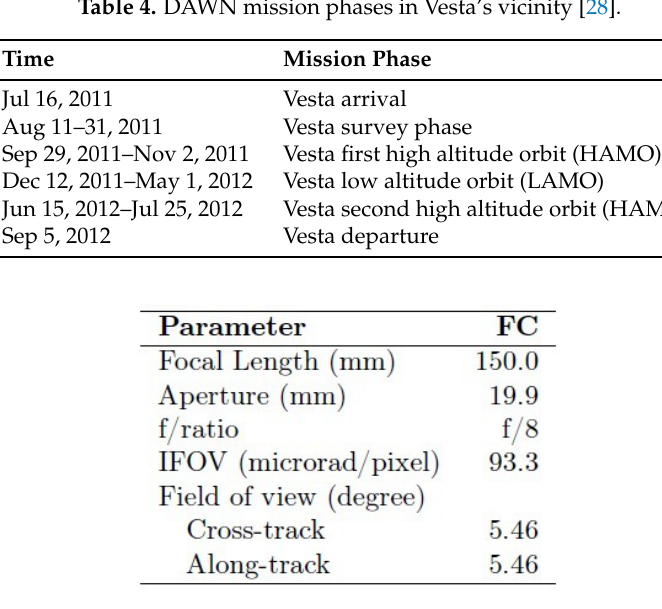
Figure 14. Basic parameters of Framing Camera 2 of the DAWN mission [24]. For the study presented here, data of the camera #ID 2 have been utilized.